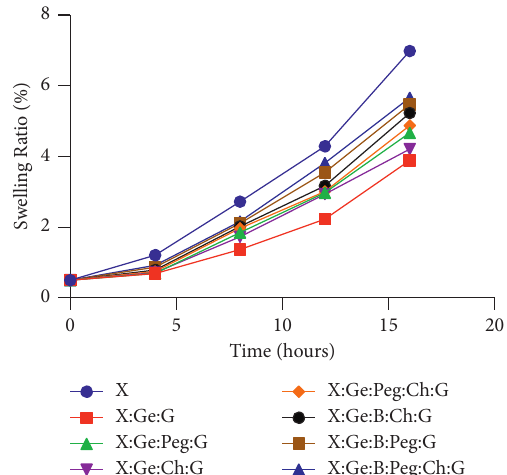
Figure 4: Biodegradability of hydrogel composites. After 21 days, all of the fabricated hydrogels showed biodegradability, with weights ranging from 0.1 to 0.24 of their initial weight. Notably, all composite hydrogels were made from 0.5g of material, and the hydrogels made from solely X had the best biodegradability. When compared to simply X hybrid hydrogels, the presence of Ge and G did not affect the degrading behavior (0.11 versus 0.10 of their initial weights). When chitosan and polyethylene glycol were combined with boric acid, the composite hydrogels (i.e., X: Ge :B: Ch:G, X :Ge : B:Peg :G, and X :Ge :B :Peg :Ch: G) showed a tendency to degrade less, possibly due to cross-linking density. Abbreviations . Xanthan gum (X), boric acid (B), gelatin (Ge), polyethylene glycol (Peg), chitosan (Ch), and glutaraldehyde